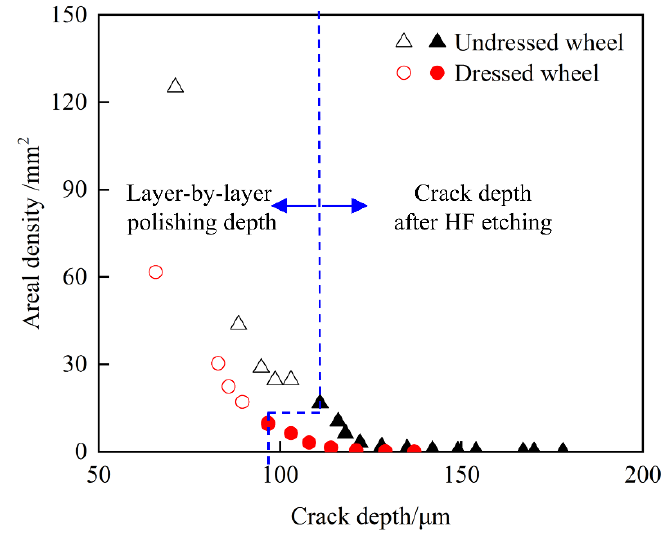
Figure 13. Variation in crack areal density with crack depth under the action of different grinding wheels.